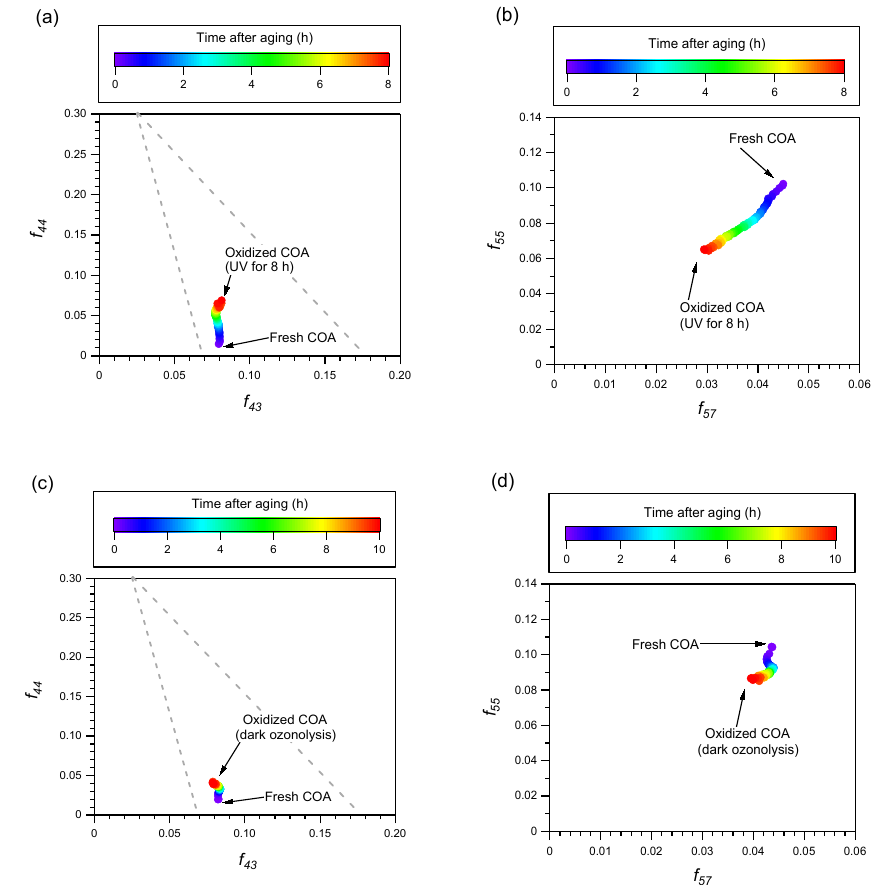
Figure 5. Scatter plot for the fractions of signal for Experiment 2 (UV for 8h) and Experiment 3. (a) f 44 to f 43 for Experiment 2, (b) f 55 to f 57 for Experiment 2, (c) f 44 to f 43 for Experiment 3, and (d) f 55 to f 57 for Experiment